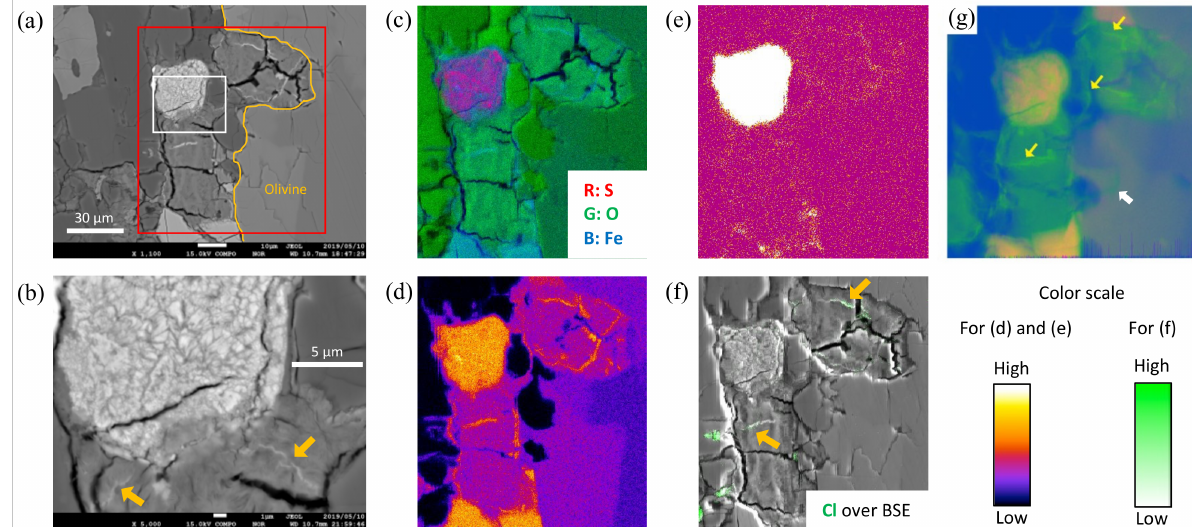
Figure 6. Survey of SO 42 − flow in the mesostasis and olivine areas by EPMA. ( a ) BSE image of a typical area showing mesostasis and olivine containing oxidized FeS in the same field of view. White square indicates the field of view in ( b ). Red square indicates the field of view in ( c ) to ( g ). ( b ) Magnified BSE image around FeS in ( a ). The orange arrows indicate the vein-like structures that migrated from FeS. ( c ) RGB image of the area near the FeS in the field of view in ( a ). Red, green, and blue indicate S, O, and Fe, respectively, and the purple color indicates FeS. ( d ) Fe distribution in the same field of view as that in ( c ). ( e ) Distribution of S (white area) in the same field of view as that in ( c ). The color balance was adjusted to enhance the low-count area. ( f ) Cl distribution (green) superimposed on the BSE image. Although its intensity is low, the Cl overlaps with the vein found in ( d) (e.g., orange arrows). ( g ) Fe valence distribution image. Red, green, and blue correspond to Fe 2+ , Fe 3+ , and Fe-free areas, respectively. The yellow arrows indicate part of the micro vein that might be the pathway for the dissolved S. The mapping energies of Fe 2+ and Fe 3+ are 7117 and 7131 eV, respectively, in the Fe K-edge XANES. The white arrows indicate the flow of this fluid into the olivine, although this was not clearly shown on the surface of the PTS owing to the 3D structure of the